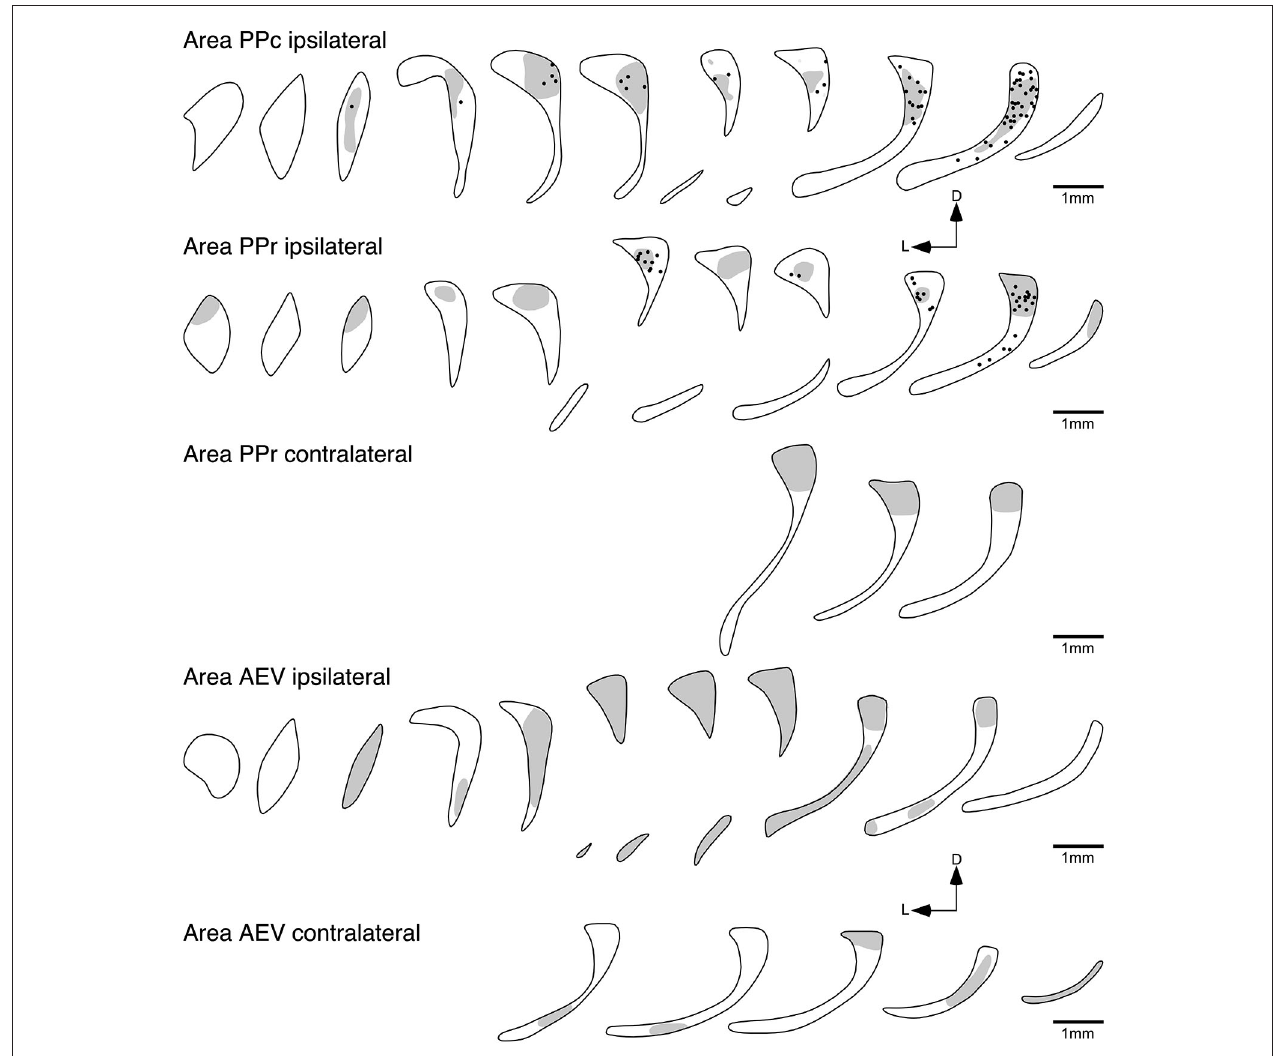
figurine medial is to the right and dorsal to the top. In each figurine, the dots represent retrogradely labeled neurons, while the shading represents regions of labeled anterograde axonal terminals. Note the widespread ipsilateral reciprocal connectivity of areas PPc and PPr, the widespread ipsilateral anterograde connectivity of area AEV, with a small amount of contralateral anterograde connectivity following injections in areas PPr and